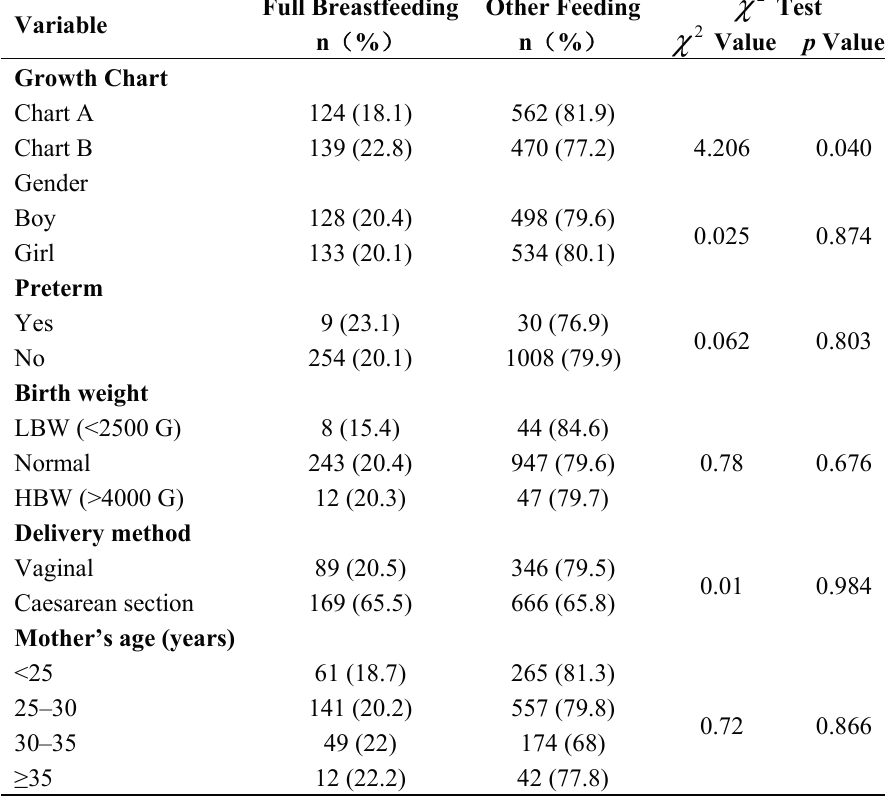
Table 3. The demographic characteristics of the ‘full breastfeeding’ group and other infant feeding at 6